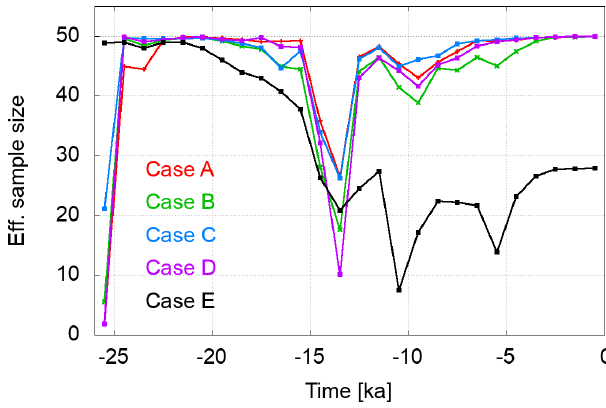
Figure 13. Variation in the effective ensemble size over time. The effective ensemble size is low in the first assimilation step if the as- sumed observation uncertainty is too low for the initial ensemble spread. The ratio between the observation uncertainty and ensem- ble variance is low for Case A and larger for Cases B and C. It is largest for Case E with very high observation uncertainties. After re- sampling and perturbation in the first assimilation step, the effective ensemble size almost equal to the nominal ensemble size. For Cases A–D, there is a reduction in the effective ensemble size after large meltwater pulses at 14.5 and 9.5ka, respectively. For Case E the ef- fective ensemble size reduces when the observation uncertainty is reduced significantly from one assimilation step to the